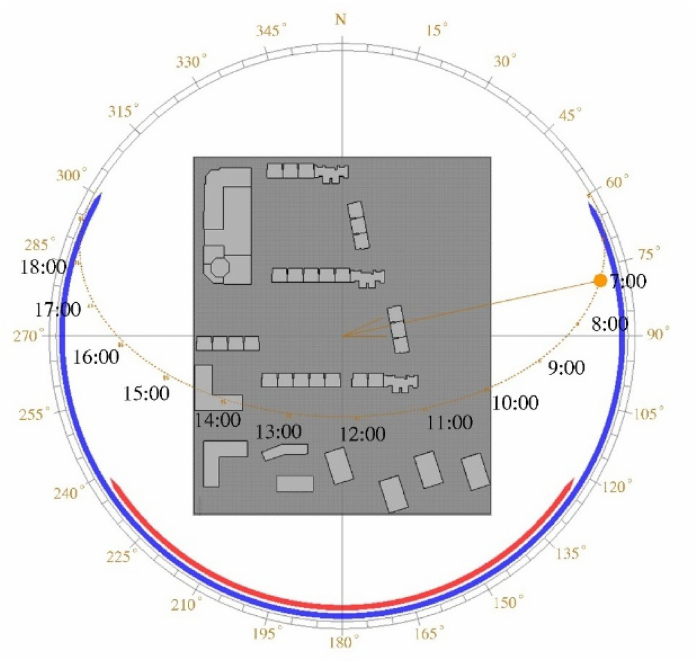
Figure 7. Solar trajectory of Beijing in